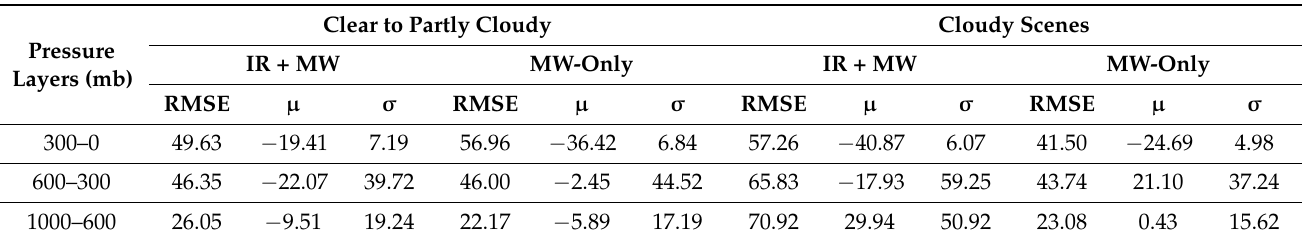
Table 2. Average water vapor (%) RMSE, bias ( µ ), and standard deviation ( σ ) for broad pressure layers. Calculations were made using Equations